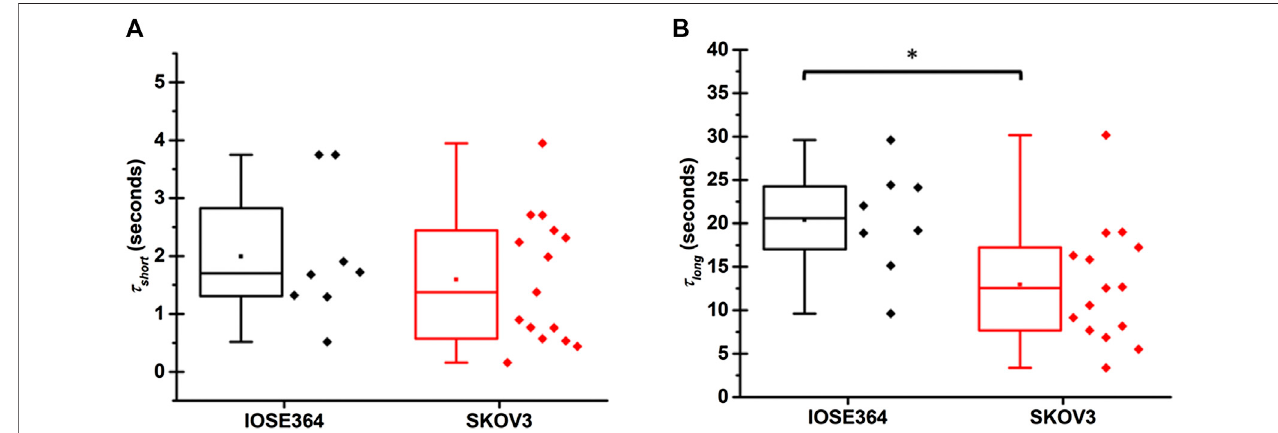
FIGURE 4 | Box-and-whisker plots for (A) short ( τ short ), and (B) long ( τ long ) characteristic times associated with tethers pulled from IOSE364 and SKOV3 cells. Number of tethers were 8 for IOSE364, and 15 for SKOV cells. Single asterisk * indicates a statistically signi fi cant different at p (cid:1)